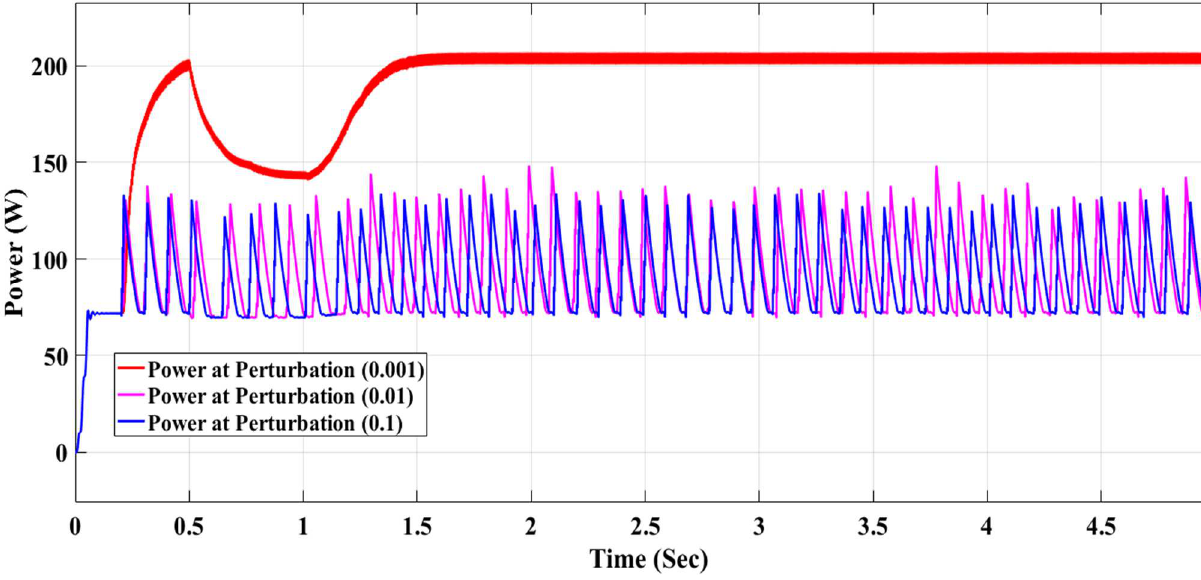
Figure 12. Power Analysis at ∆ D = 0.001, ∆ D = 0.01 and ∆ D = 0.1 for PV